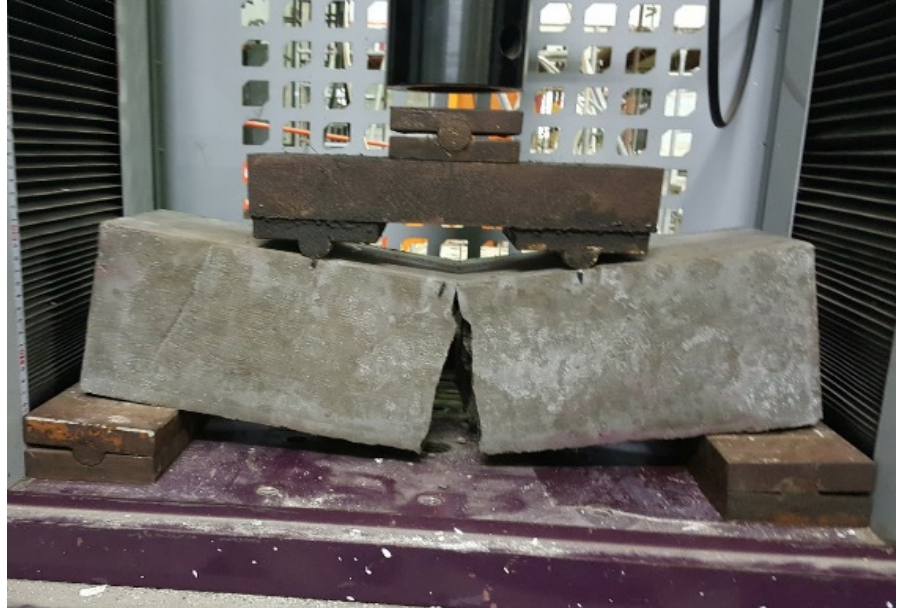
Figure 9. Rupture modulus of high strength concrete beam setup.